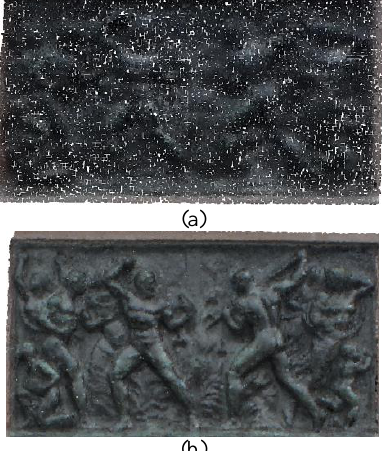
(b) Figure 24. (a) Video based point cloud (30000 points) of the sculpture. (b) Still image based point cloud (74000 points) of the